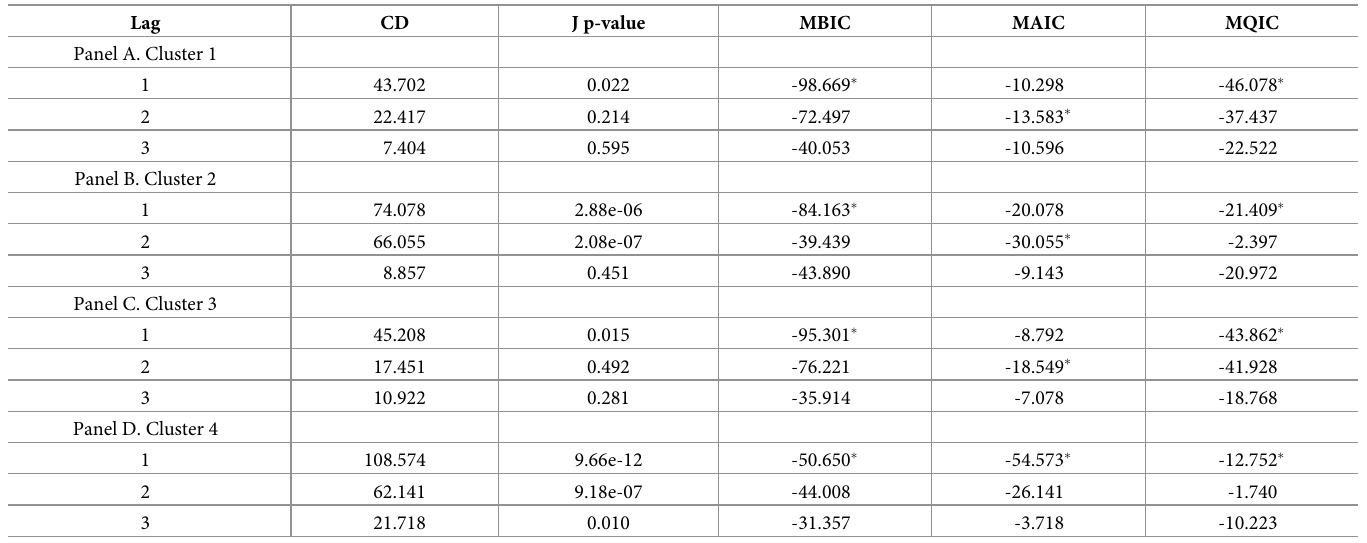
Table 8. Optimal lag length tests of the Panel VAR model under different country categories.